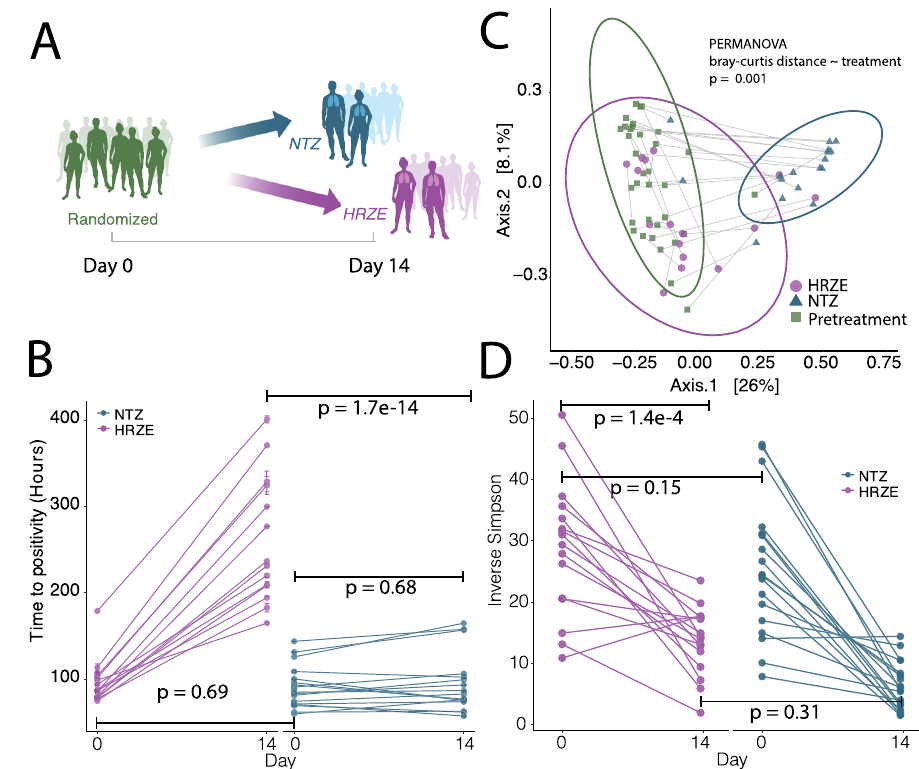
Fig. 2 Both HRZE and NTZ perturb the gut microbiota after two weeks of therapy, but only HRZE reduces M. tuberculosis bacterial load. A Schematic of the clinical trial comparing bactericidal effect of HRZE and NTZ. B Paired M. tuberculosis sputum time to positivity (TTP) at day 0 and day 14 for the NTZ treatment arm and HRZE treatment arm. Data are displayed as range (minimum and maximum) of two-three technical replicates; n = 16